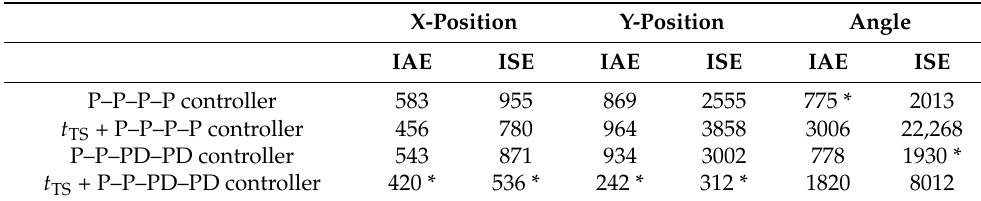
Table 4. IAEs and ISEs by each controller in tracking of 8-shaped trajectory. X-Position Y-Position Angle IAE ISE IAE ISE IAE